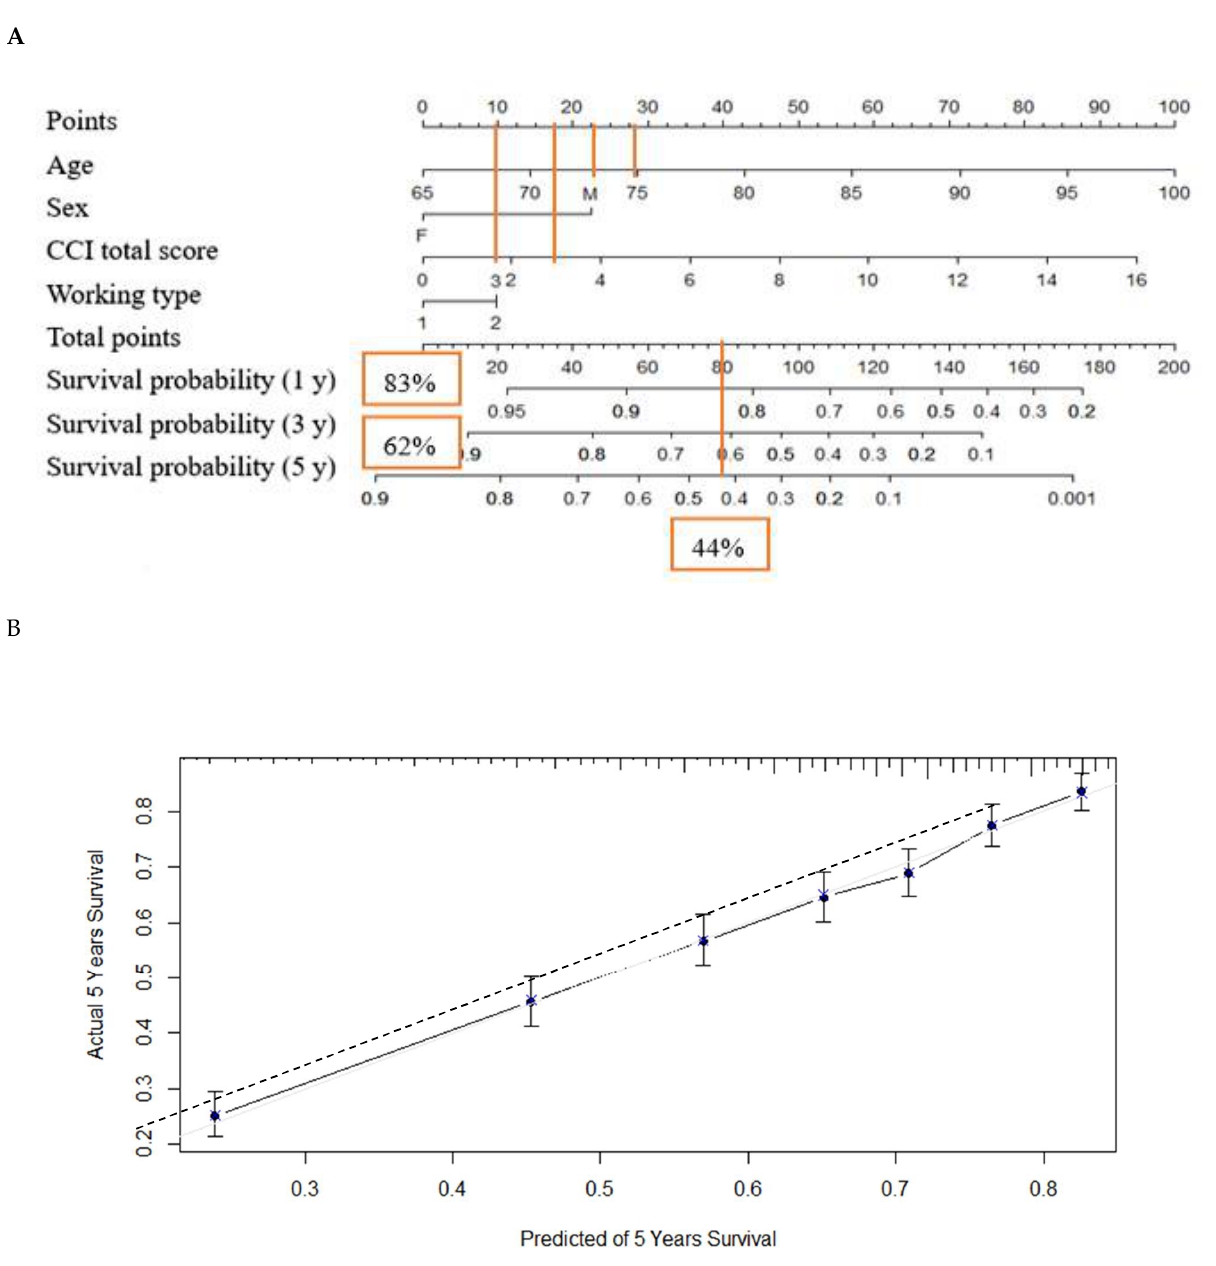
Figure 3. ( A ) Nomogram predicting 1-, 3- and 5-year survival probabilities. The sum of the scores for each variable was plotted on the total points axis (the horizontal line at the top,) and the estimated probabilities of survival at 1, 3 and 5 years were obtained by drawing a line vertically from the plotted total point axis straight to the survival axis. ( B ) Calibration plots comparing nomogram-predicted (- - - - -) and actual ( ) survival probabilities at 5 years.